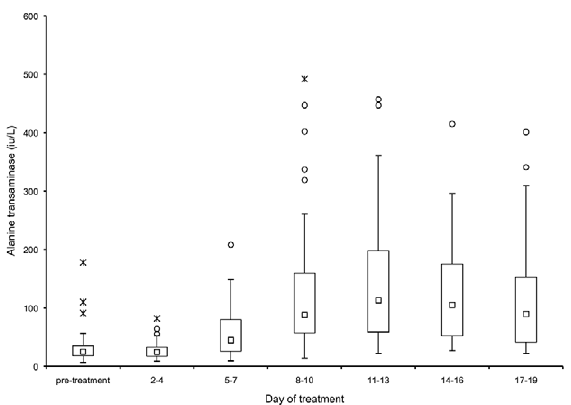
Figure 3. Box-and-whisker plot of serum alanine transaminase concentrations against duration of treatment with sodium stibogluconate (SbV). The group median (squares) rose significantly by day 10 after initiation of treatment ( p , 0.001). Outliers are depicted by circles, extremes are depicted by hashes.